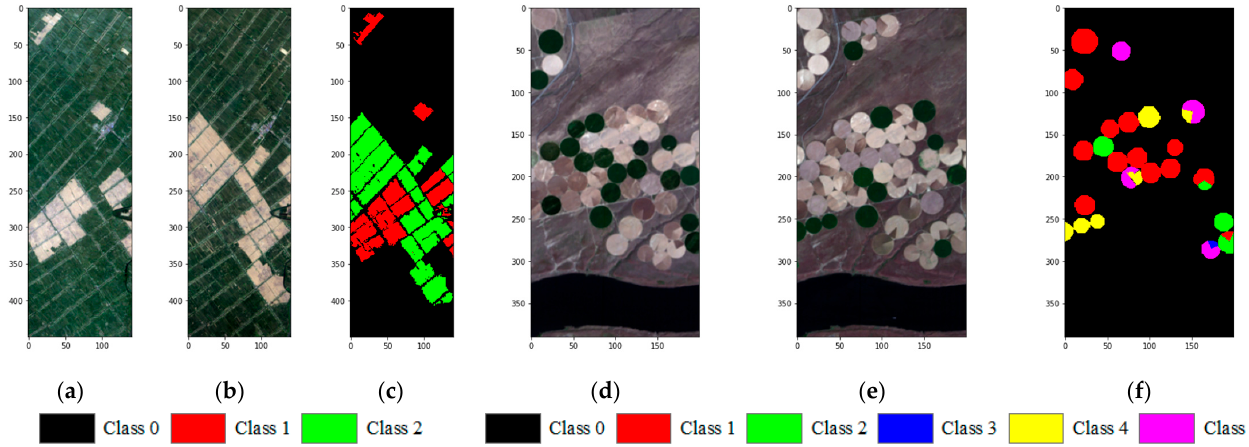
Figure 6. Real multitemporal image dataset-1 and dataset-2: False-colour composites (bands: R: 23, G: 13, B: 6) images: Farmland images acquired on ( a ) 3 May 2006, and ( b ) 23 April 2007, and ( c ) reference image. False-colour composites (bands: R: 23, G: 13, B: 6) images: Agricultural irrigated images acquired on ( d ) 1 May 2004 and ( e ) 8 May 2007, and ( f ) reference image.